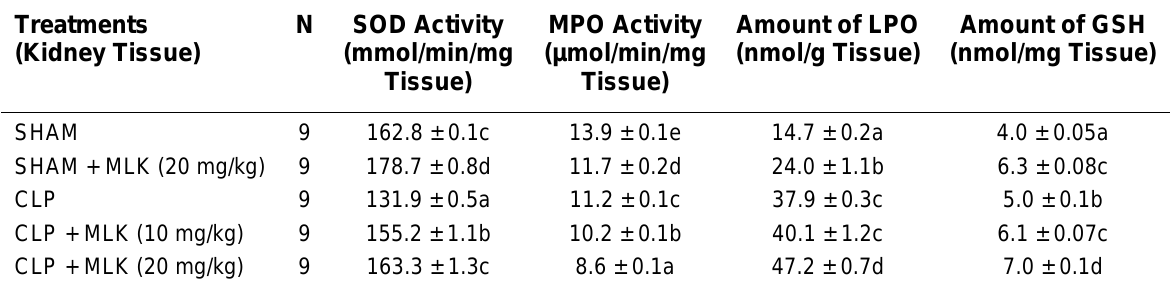
Effects of MLK Treatments on Changes in Activities of MPO and SOD, and with Levels of LPO and GSH in Kidney Tissues of Rats